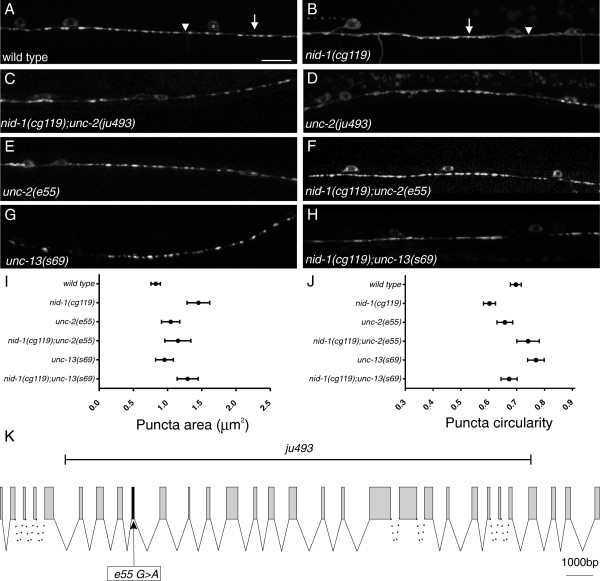
unc-2 mutations suppress SNB-1::GFP defects in nid-1. (A) In wild type animals synaptic vesicles accumulated in evenly spaced puncta (arrow) with smooth morphology (arrowhead). Cell bodies (asterisks) are also visible. Scale bar equals 10 μm. (B) Animals lacking nidogen accumulated synaptic vesicles in elongated (arrow) puncta. Diffuse GFP was often present in regions between puncta (arrowhead). (C) The ju493 mutation suppressed the large aggregations of SNB-1::GFP seen in nid-1 mutants. (D, E) Mutations in unc-2 (D - ju493, E - e55) resulted in slightly larger puncta, but the morphology and distribution were more similar to wild type than nid-1, even when nid-1 was absent (F). (G) unc-13(s69) animals had a slight decrease in the number of puncta, but the morphology was not grossly affected. (H) In the nid-1(cg119);unc-13(s69) double mutants puncta were elongated similar to nid-1 single mutants. (I, J) We quantified puncta area (K) and circularity (L) for each analyzed genotype and plotted them as mean (circle) with the 5 to 95% confidence interval (whiskers). (K) A cartoon of the genomic region of unc-2 with the position of alleles used indicated. Exon/introns are to scale, except for dashed lines, which indicate larger introns. The e55 allele is a G > A nucleotide change in exon 9 that results in Q571 to stop [Wormbase: CE42155]. The ju493 deletion removes a large part of the coding segment, corresponding to the exons encoding AA144-1888. All animals in these micrographs are young adults (1 to 2 days post 4th larval stage (L4)).